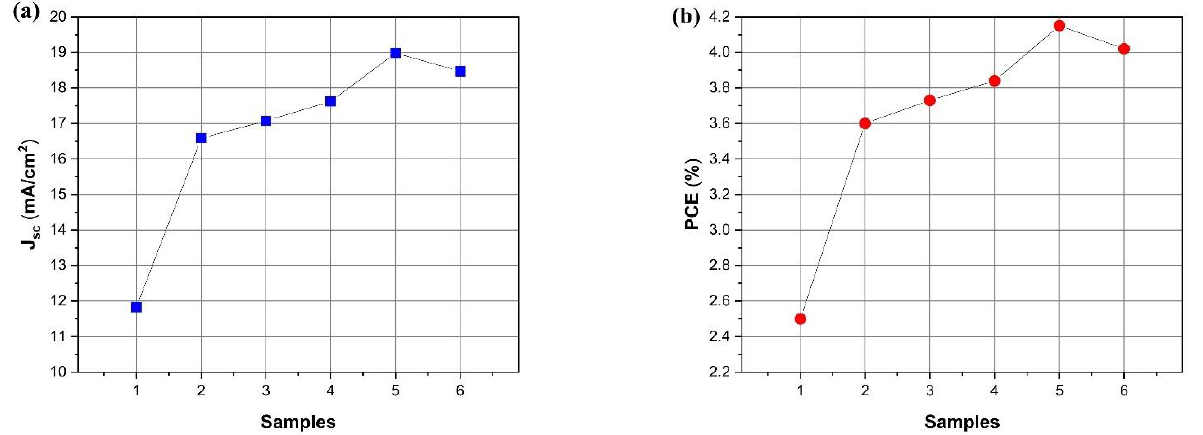
Figure 7. ( a ) Jsc and ( b ) PCE of the devices with and without NPs